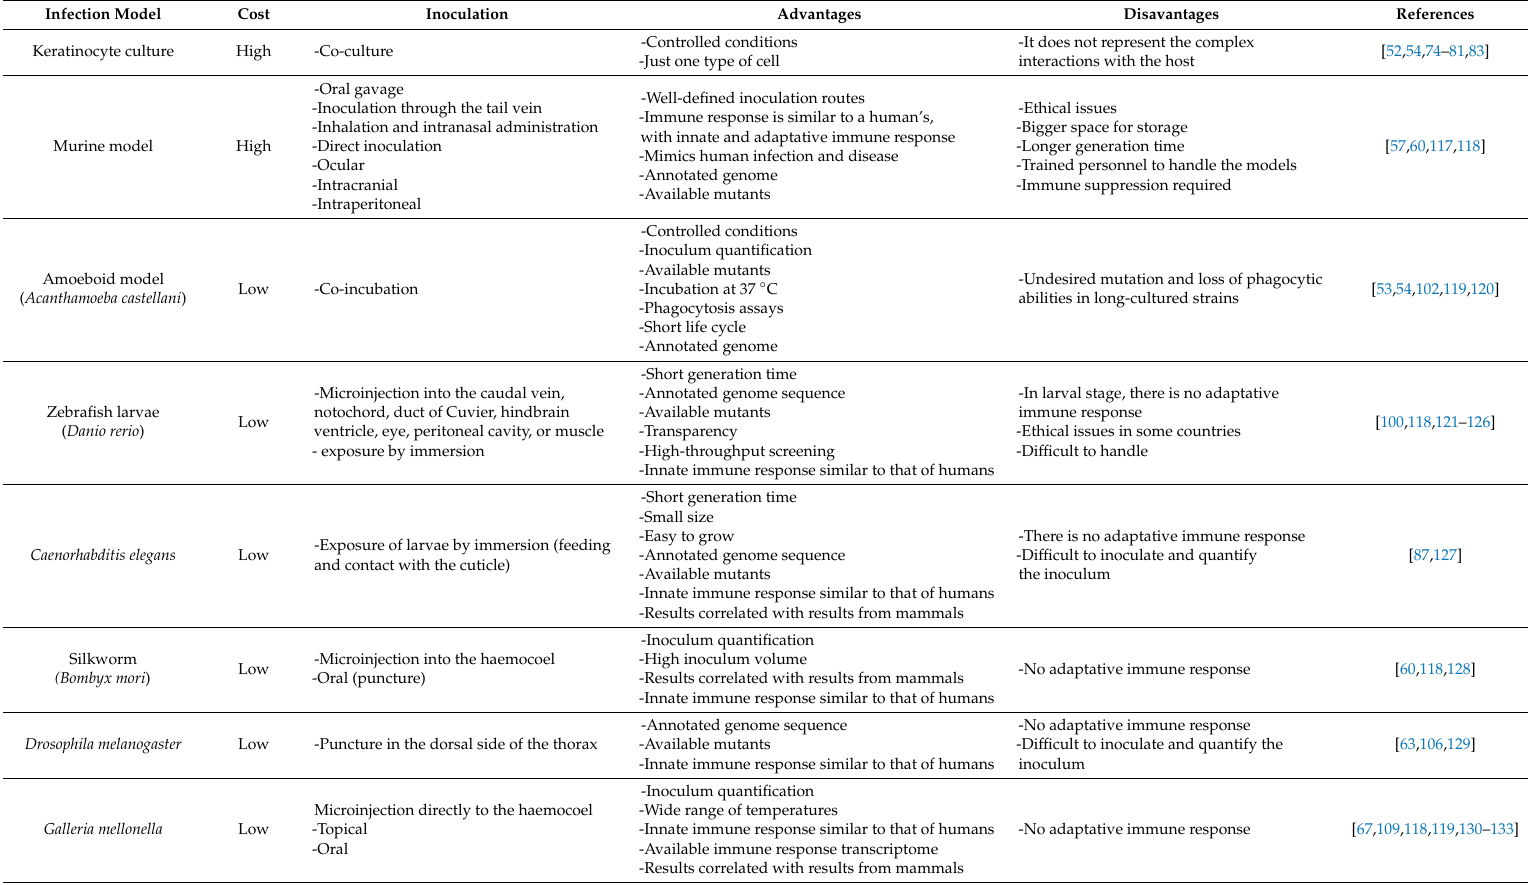
Table 2. In vitro and in vivo models available for Malassezia spp. infection